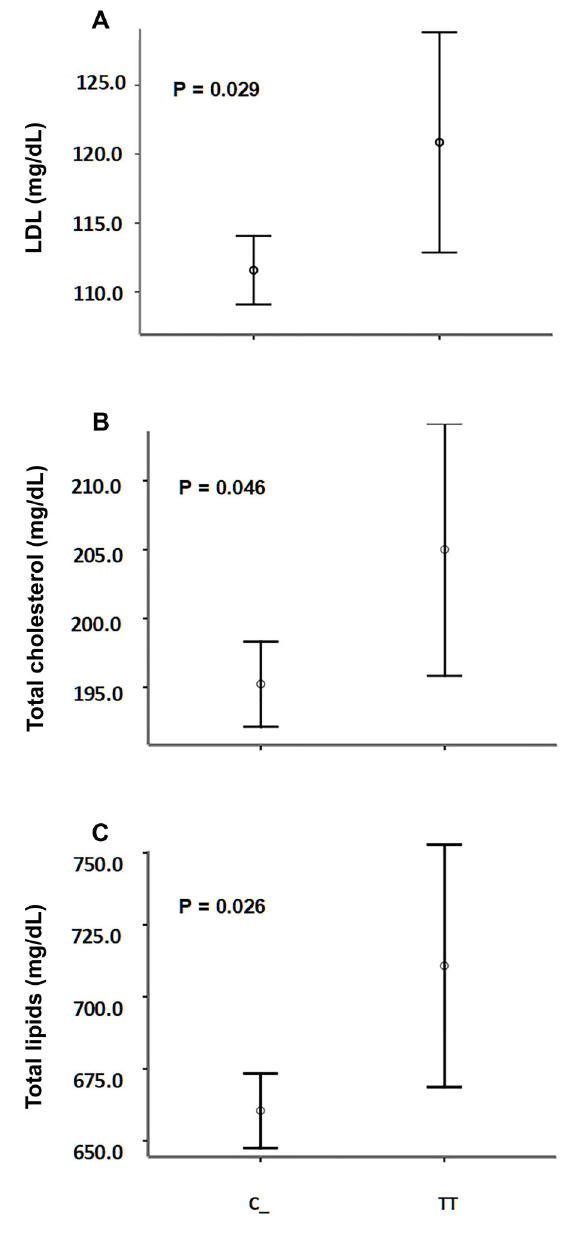
Figure 1. Circulating levels of LDL ( A ), total cholesterol ( B ), and total lipids ( C ) among carriers and non-carriers of the C allele of the apoB rs693 polymorphism. Signi fi cance was determined by Student ’ s t -test. Vertical bars represent intervals of two standard error